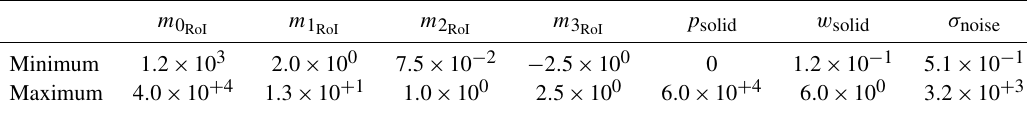
Table A1. Ranges of parameters used for the generation of the synthetic spectral